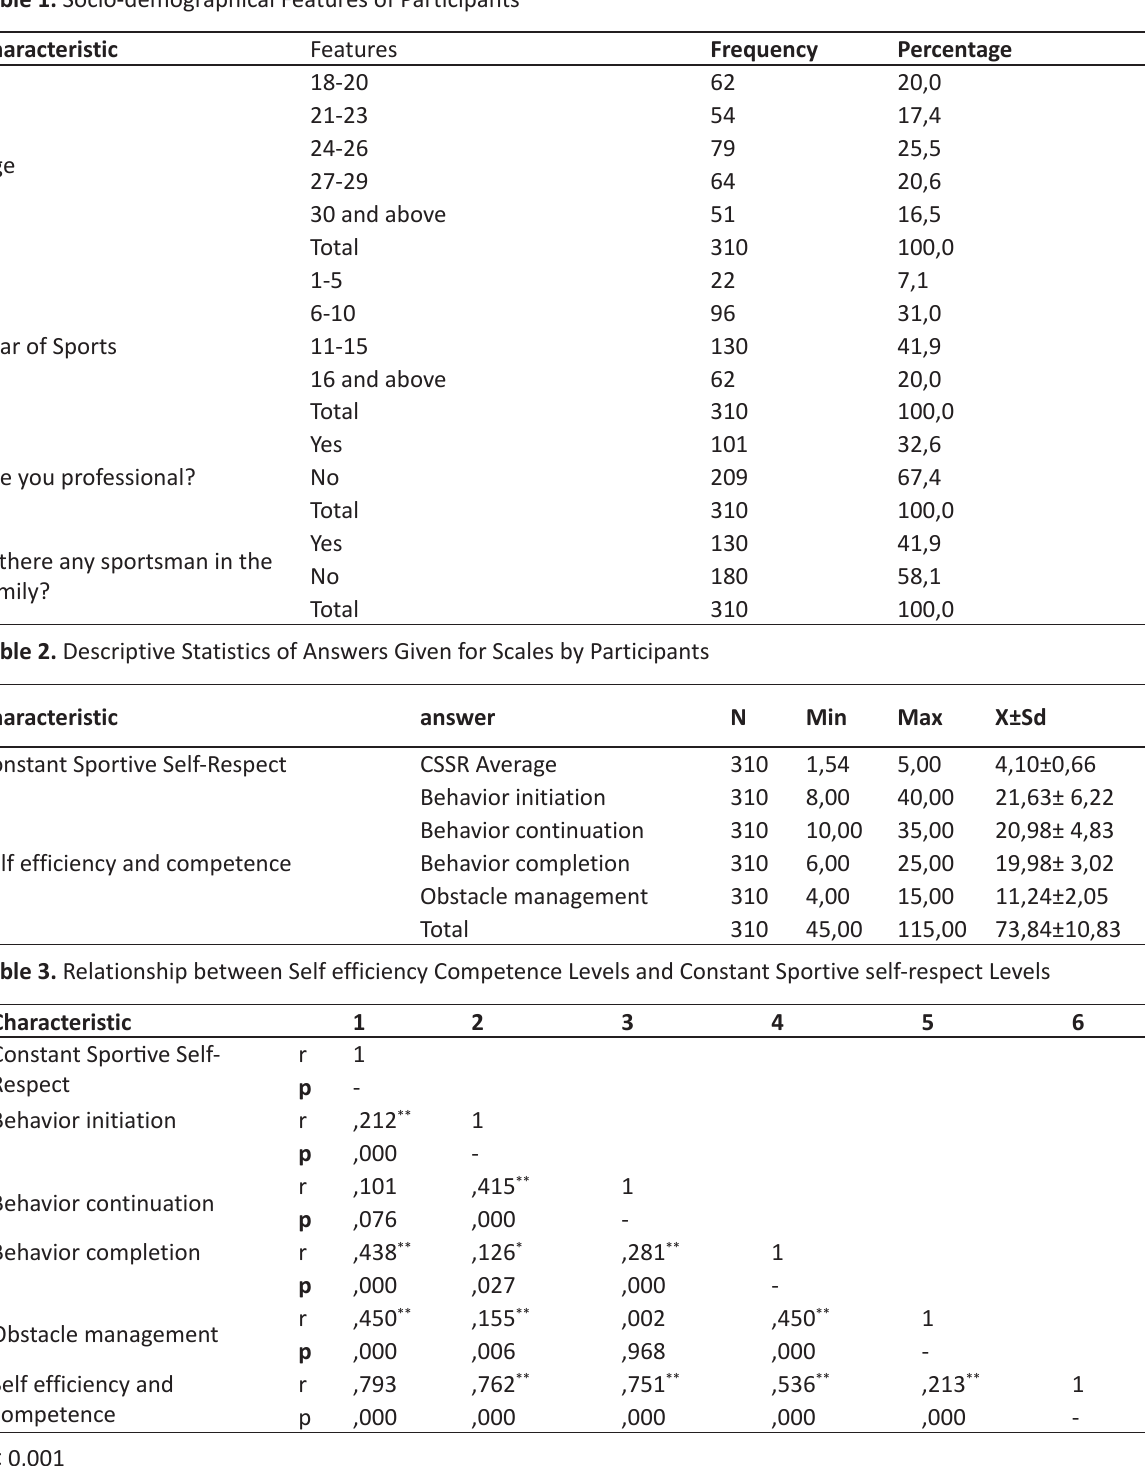
Table 4. Regression Analysis relating to Prediction of Constant Sportive self-respect Level